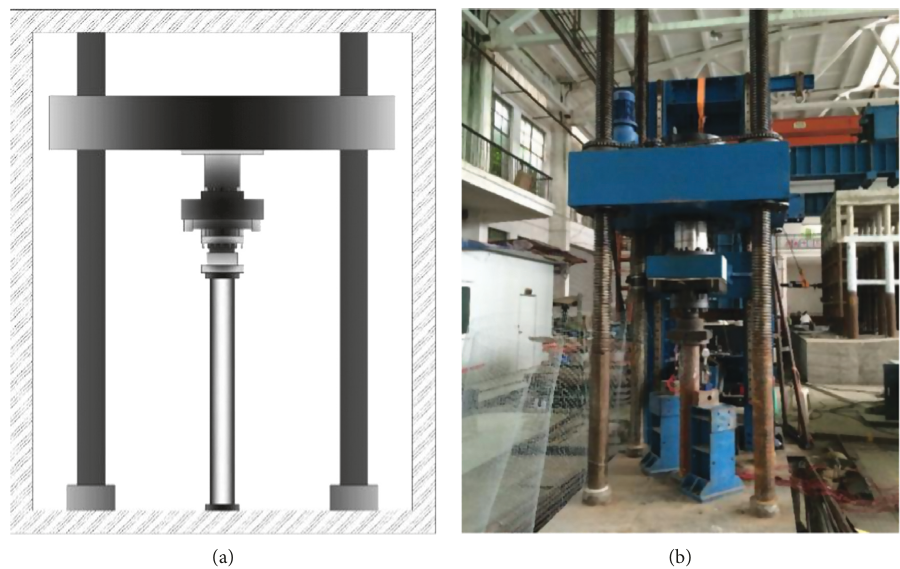
Figure 2: Test setup. (a) General view. (b) CFST detail.